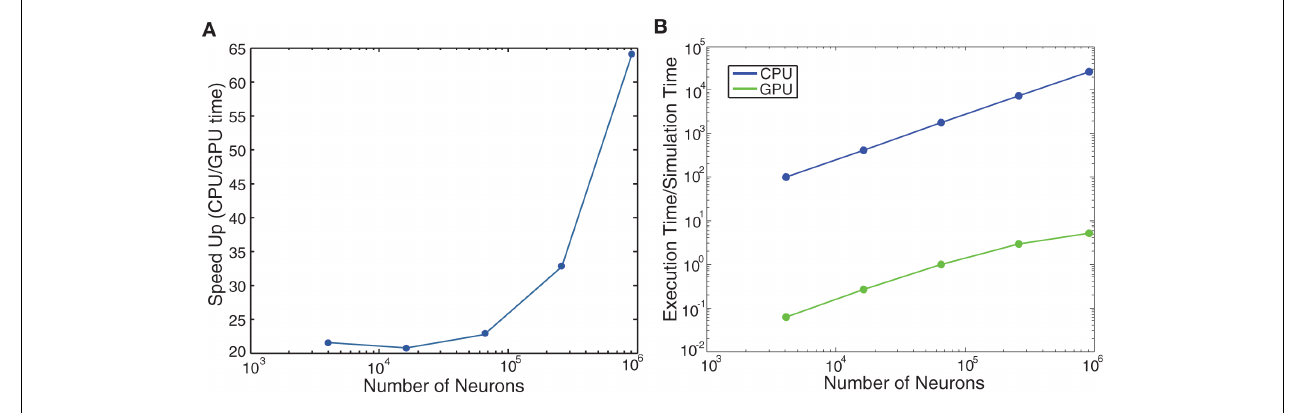
Speedup, which is given as the ratio of CPU to GPU execution time. (B) Simulation speed, which is given as the ratio of GPU execution time over